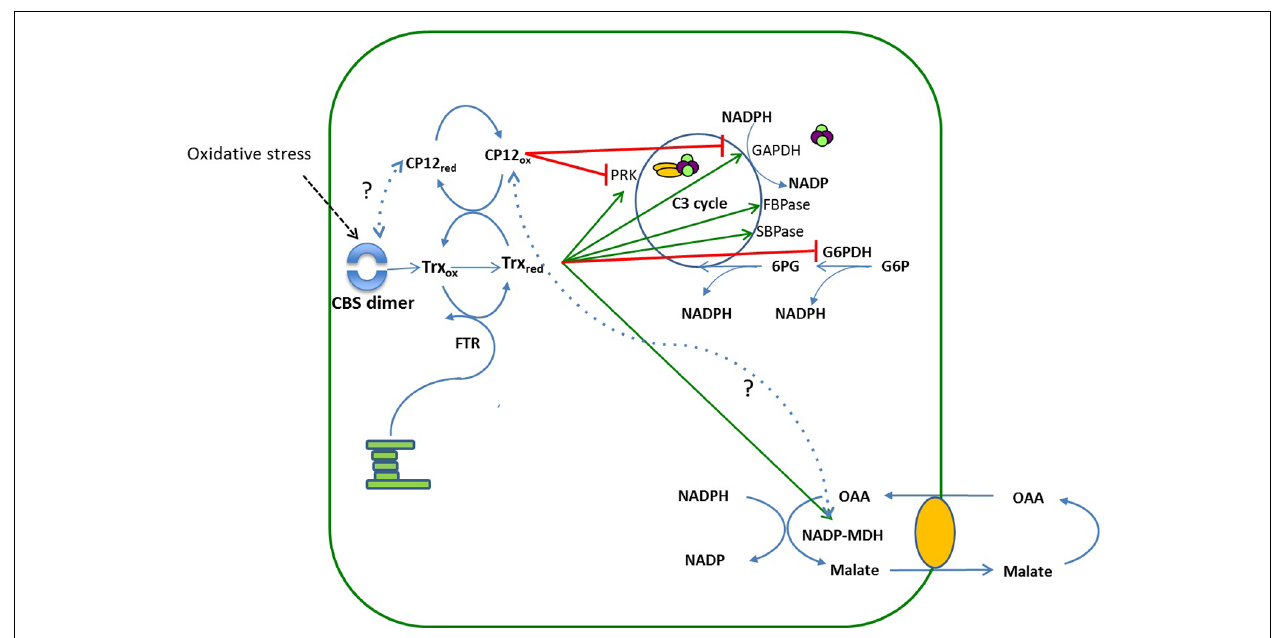
state also increase resulting in the formation of the PRK/GAPDH/CP12 complex and inactivation of PRK and GAPDH. Under oxidative stress dimerization of the plastid CBSX1 protein occurs, which increases the levels of reduced Trx, thereby maintaining CP12 in the reduced state. The green arrows indicate the Trx mediated activation of the enzymes GAPDH, PRK, SBPase, FBPase, and MDH and the red bars indicate deactivation of PRK and GAPDH by CP12 mediated formation of the complex or of G6PDH by reduced Trx. Dotted lines indicate hypothetical interactions between CBSX1 and CP12red and CP12ox and